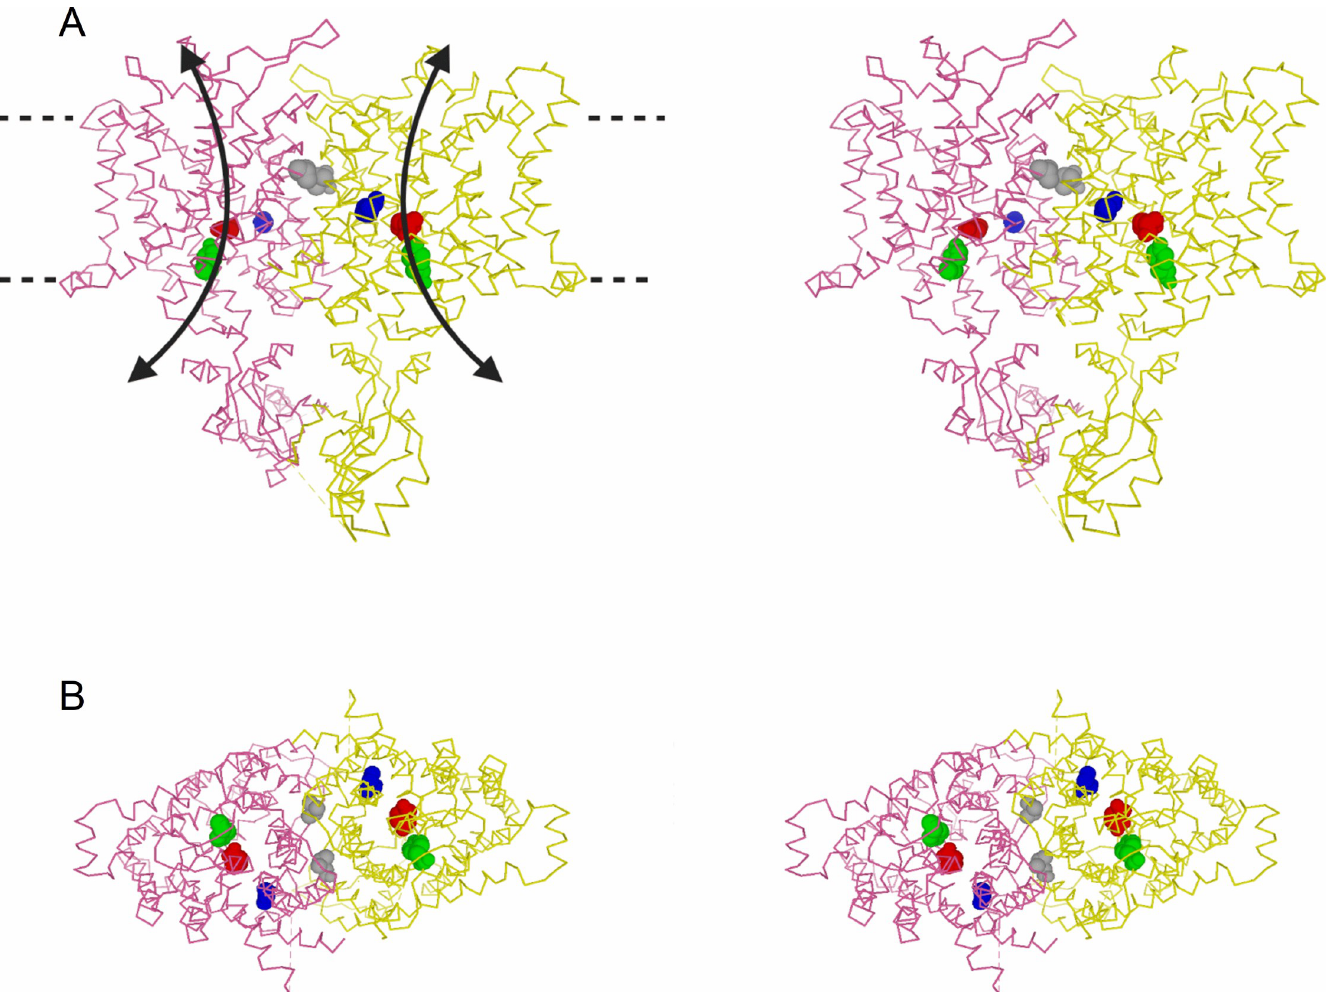
Fig 1. Structure of vertebrate CLC channels. Structure of human CLC-1 molecule (PDB accessing code: 6QVU) is used to represent the structure of CLC-0, which is still not available. CLC-0 residues mutated in this study are depicted by the colored and space-filled corresponding CLC-1 residues (in parenthesis): Blue, C212 (C277 of CLC-1); Grey, V490 (I556); Green, Y512 (Y578). The “E-gate” residue, E166 of CLC-0 (E232 of CLC-1), is also shown as a space-filled residue (red). (A) Stereo-view of hCLC-1 structure viewed from within membrane phospholipids (side view). Curved arrows depict the ion permeation pathways. Dotted lines indicate the extracellular and intracellular edges of lipid membranes. (B) Stereo-view of hCLC-1 viewed from the cytosolic side.